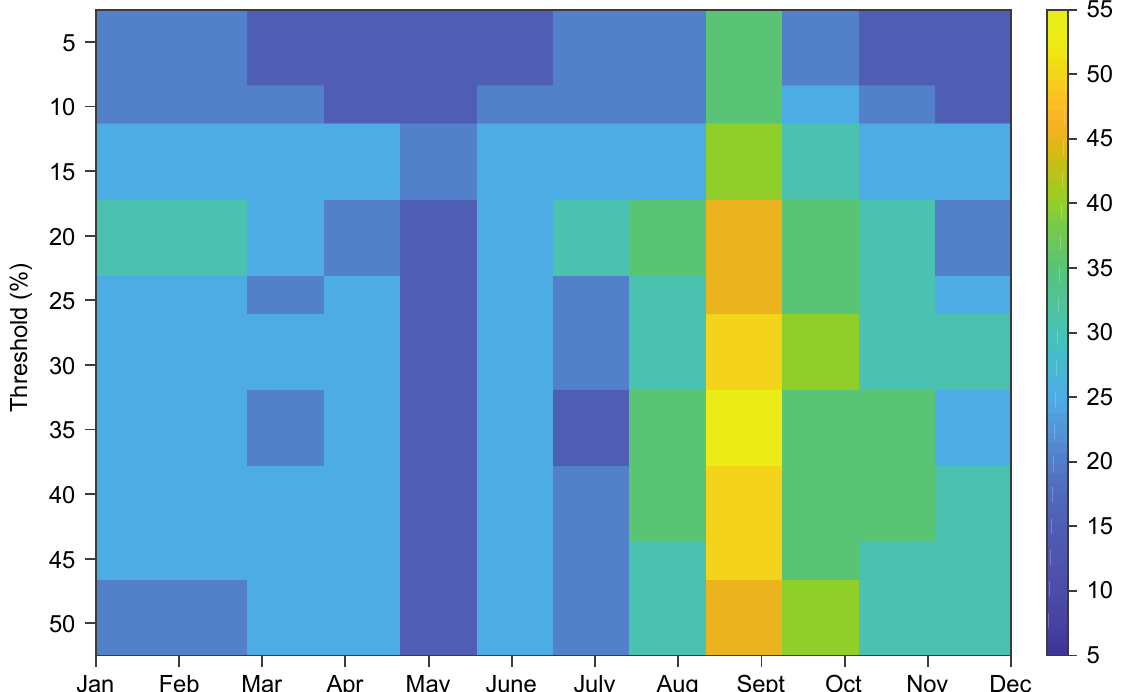
Figure 4. The width of the threshold range for which data comes from the same distribution, as evaluated by two-sample Kolmogorov–Smirnov tests, both as a function of month and threshold. For example, when looking at May, the distribution of SIE values resulting from a 10% threshold choice is not significantly different from distributions of SIE values resulting from 5% or 15% threshold choices. Thus, the width of the range for which data comes from the same distribution is 10.